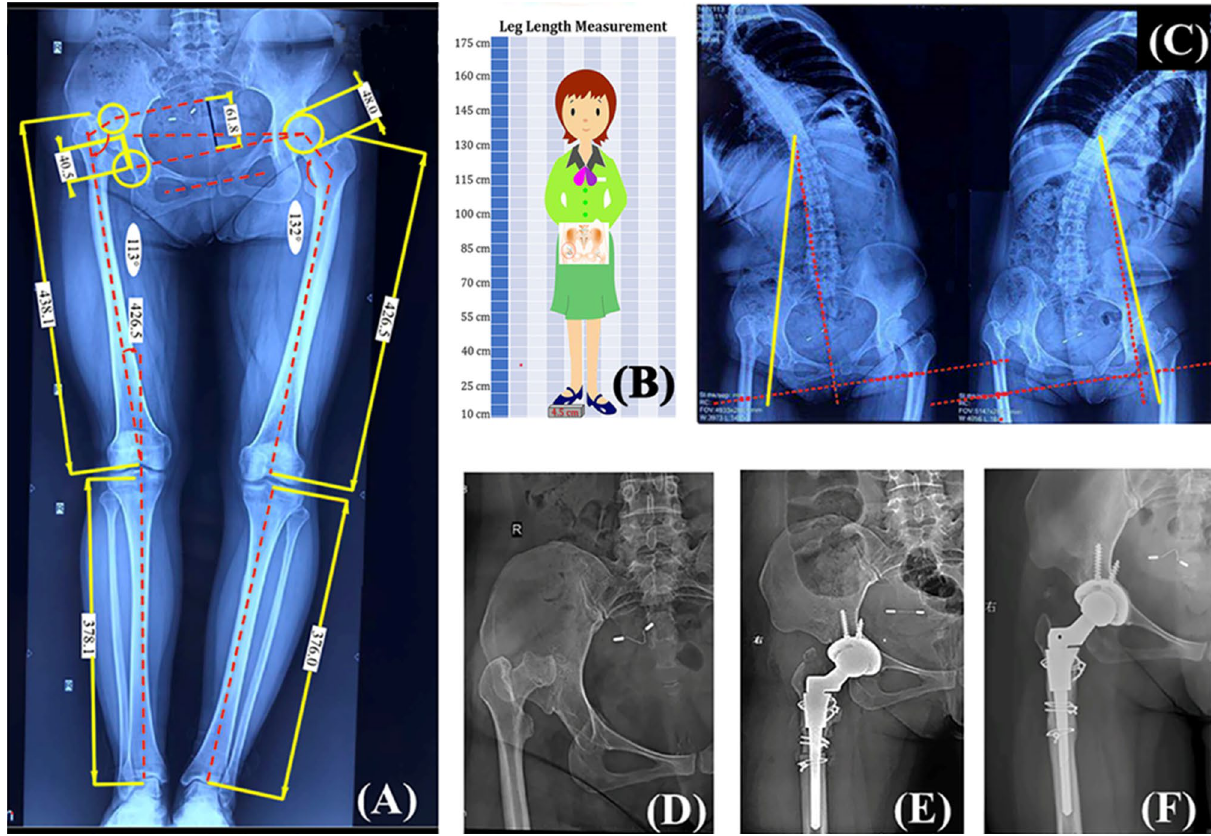
Figure 1. Preoperative planning and surgical treatment of a 37-year-old male patient diagnosed as Crowe type IV DDH by DAA THA combining STO. ( A ) Preoperative planning and lower limb length balancing by standing full-length anteroposterior radiographs. A stepwise algorithm for limb length equalization was implemented based on measurements of the hip dislocation height, the anatomical lengths of the lower limbs, the pelvic tilt angle, intra-articular and extra-articular deformities as indicated. ( B ) The limb length discrepancy was further evaluated by a scaled block under the ipsilateral foot in our measuring system. ( C ) Bilateral bending X-ray of lumbar spine were obtained to estimate the flexibility of the lumbar-pelvic complex. ( D , E ) Preoperative and postoperative anteroposterior hip radiographs. This patient was further balanced by STO within direct